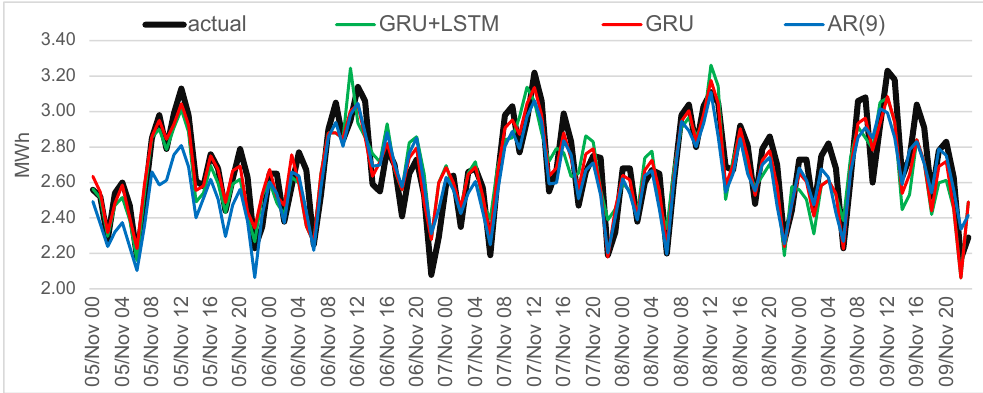
Figure 6. Comparison between the actual and the forecasted values with GRU, GRU+LSTM and AR methods.